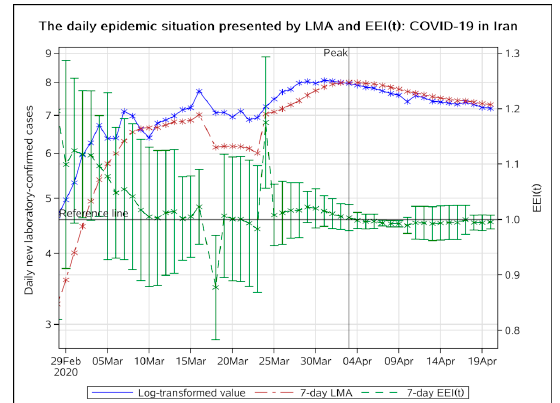
Figure 7. The daily epidemic situation presented by LMA and EEI(t), COVID-19 in Iran. The blue line indicates the change of the log-transformed value over date. The brown line indicates the change of 7-day LMA over date. The green line indicates the change of the EEI(t) over date. LMA, moving average of log-transformed daily new cases and EEI(t), epidemic evaluation index (t).